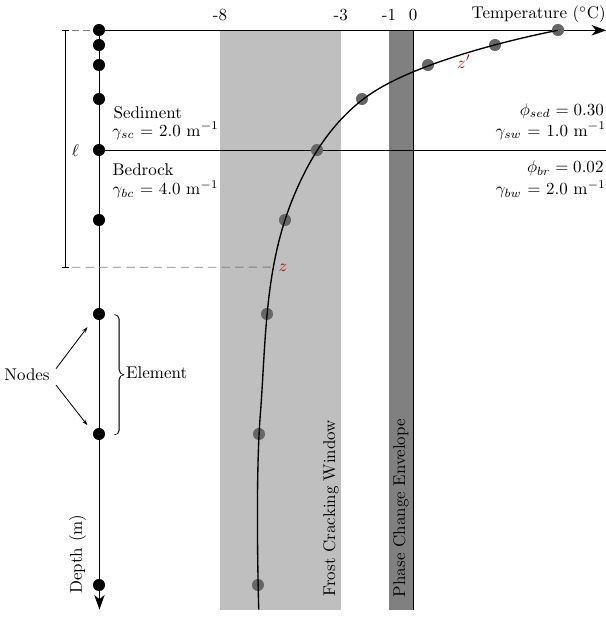
Figure 2. Schematic of the model set-up. The water volume avail- able for frost cracking in an element at depth z in the frost-cracking window is found by multiplying the porosity, φ , the water fraction, w f , and the integrated flow resistance, (cid:48) , of all elements along the path (cid:96) . The integrated flow resistance from an element containing water ( z (cid:48) ) to z is found by integrating the element flow resistance ( γ ) along the path between z and z (cid:48) . The magnitude of γ depends on the thermal state and porosity of each element. Bc: cold bedrock; bw: warm bedrock; sc: cold sediment; sw: warm